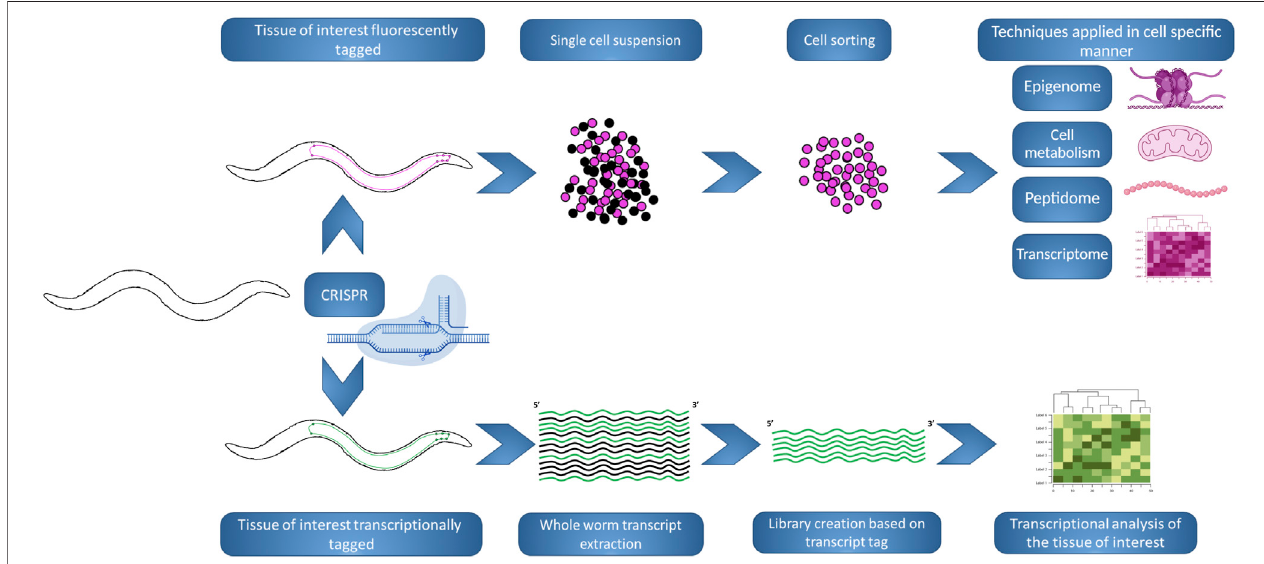
FIGURE5| Innovativework fl owsusing C.elegans tostudyNDs.Thedevelopmentofnewwork fl owsandortechniquesinthenematodeallowsfornewsscopesin the study of NDs, allowing to switch between whole-organism to single cell perspectives, at one ’ s convenience. (Top). Astrain can be generated byCRISPR in order to tag with a fl uorescence marker (pink) the tissue of interest. Posteriorly, large synchronized populations of the strain can be raised and chemically digested, in order to obtain a cell suspension that be FACS sorted based on the fl uorescence tag. The resulting sorted population can be used in different analyses and techniques, where small variations could be masked if analysing whole worms. (Bottom). A strain can be generated by CRISPR in order to tag biochemically (green) the transcripts produced in the tissue of interest. Posteriorly, largesynchronizedpopulationsof thestraincan be raised and whole organism extraction is performed, butthe creation